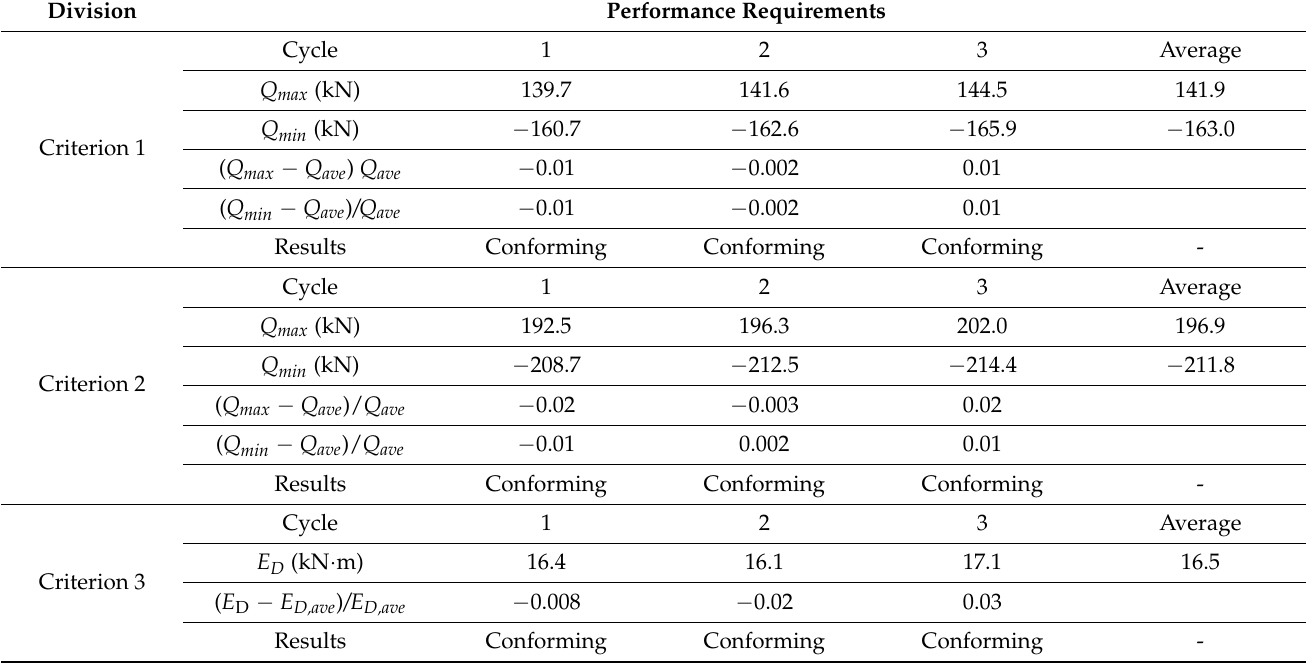
Table 7. Conformance evaluation of NBSD − 2 as a seismic control